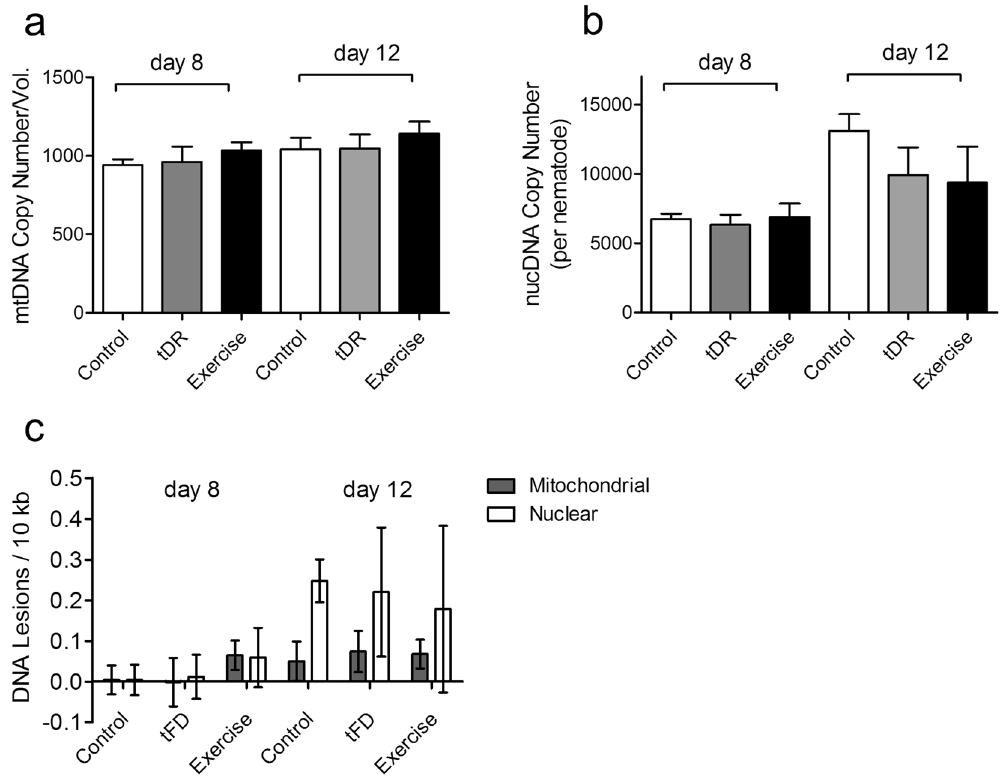
Figure 3. Exercise does not change mitochondrial or nuclear DNA copy number, nor does exercise reduce DNA damage. Panel a, mitochondrial DNA copy number and Panel b, nuclear DNA copy number, determined as previously described 29 . Panel A y-axis represents relative copy number (absolute mitochondrial DNA copy number divided by worm volume) due to size differences between groups, while Panel B y-axis represents absolute nuclear DNA copy number due to all animals having a fixed number of cells. There were no significant differences between treatment groups at either time point, as determined by one-way ANOVA. Panel c, DNA lesions in mitochondrial and nuclear genomes were determined by long QPCR amplification as described 29 . Day 8 control animals were considered to be baseline lesion levels in the analysis; thus, all lesion scores are relative to lesions in the control animals. Data shown are the average of three technical replicates (each from a pooled sample of 6 worms) and two biological replicates. Error bars represent the standard error of the